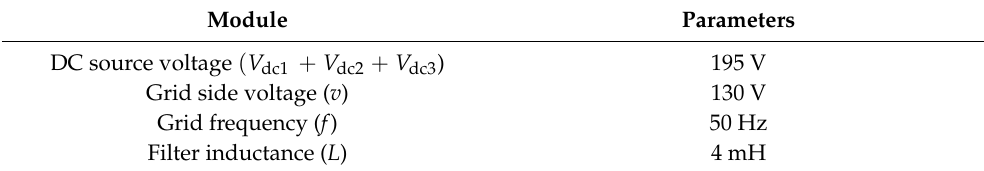
Table 4. The parameters used in the